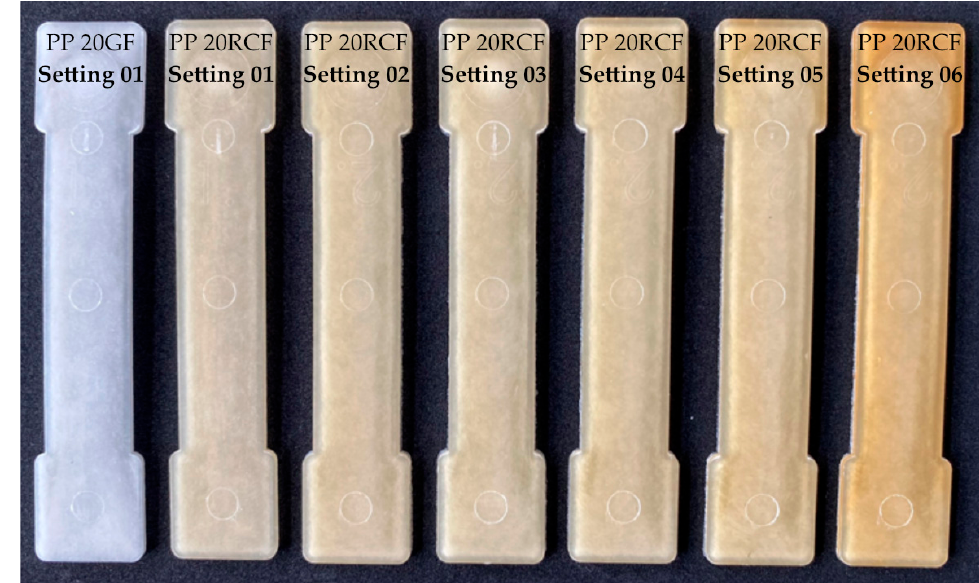
Figure 5. Representative specimens of PP 20GF (Setting 01) and PP 20RCF (Setting 01 to Setting 06).